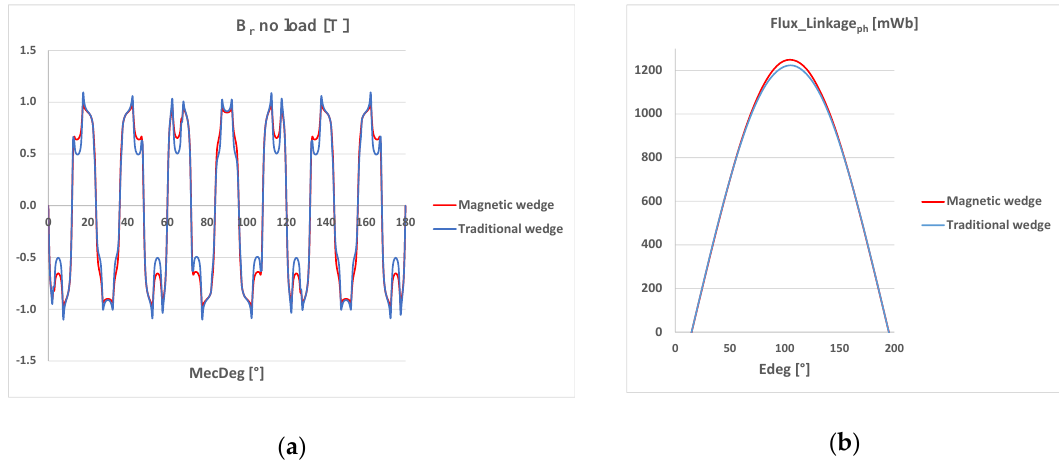
Figure 12. ( a ) Radial component of airgap flux density under no load; ( b ) Flux linkage with one